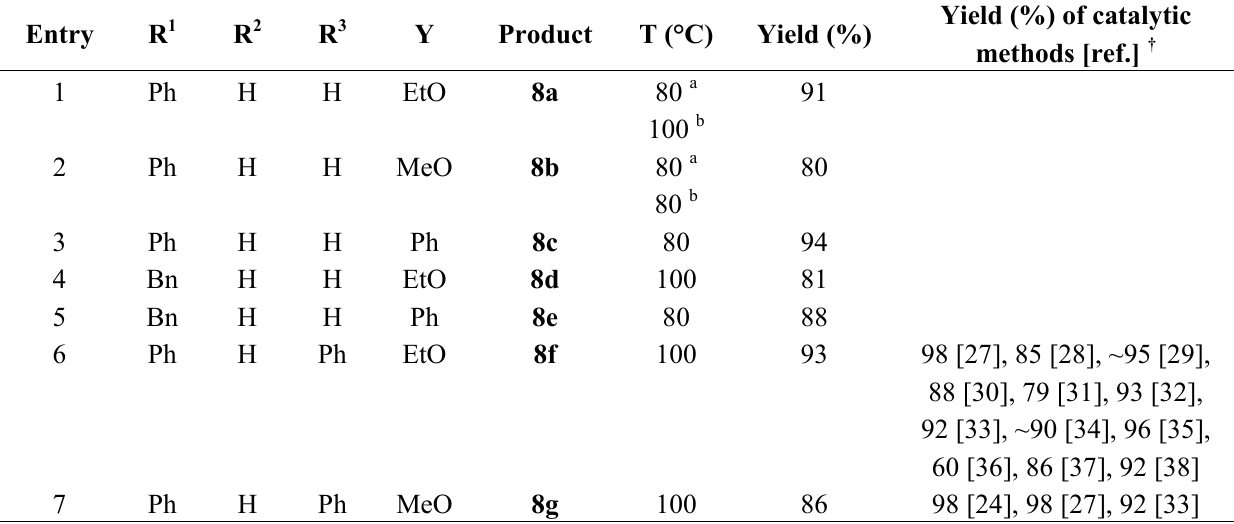
Table 2. Kabachnik–Fields reactions carried out without the use of a solvent and a catalyst under MW irradiation